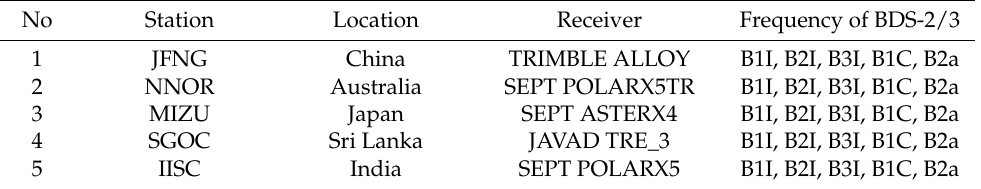
Table 3. Station information for the static experiment.